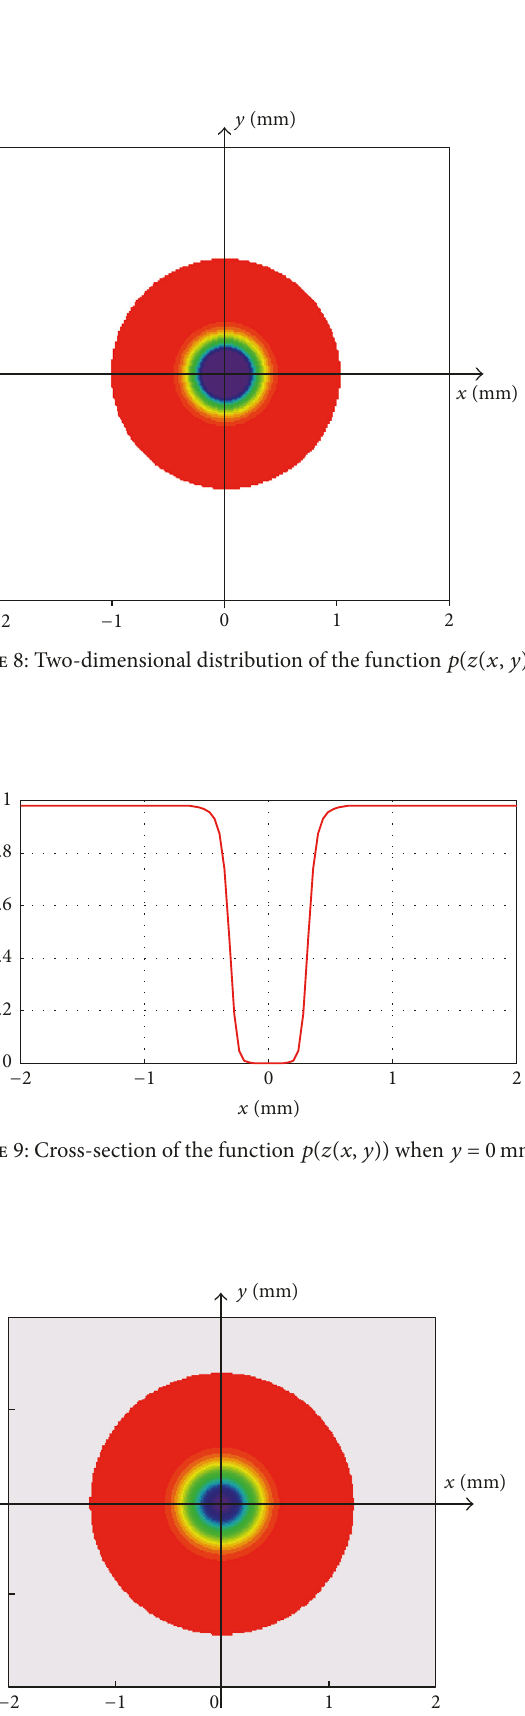
Figure 10: Distribution 𝐼 𝑘 (𝜏 𝑥 , 𝜏 𝑦 ) , obtained through numeric meth- ods.